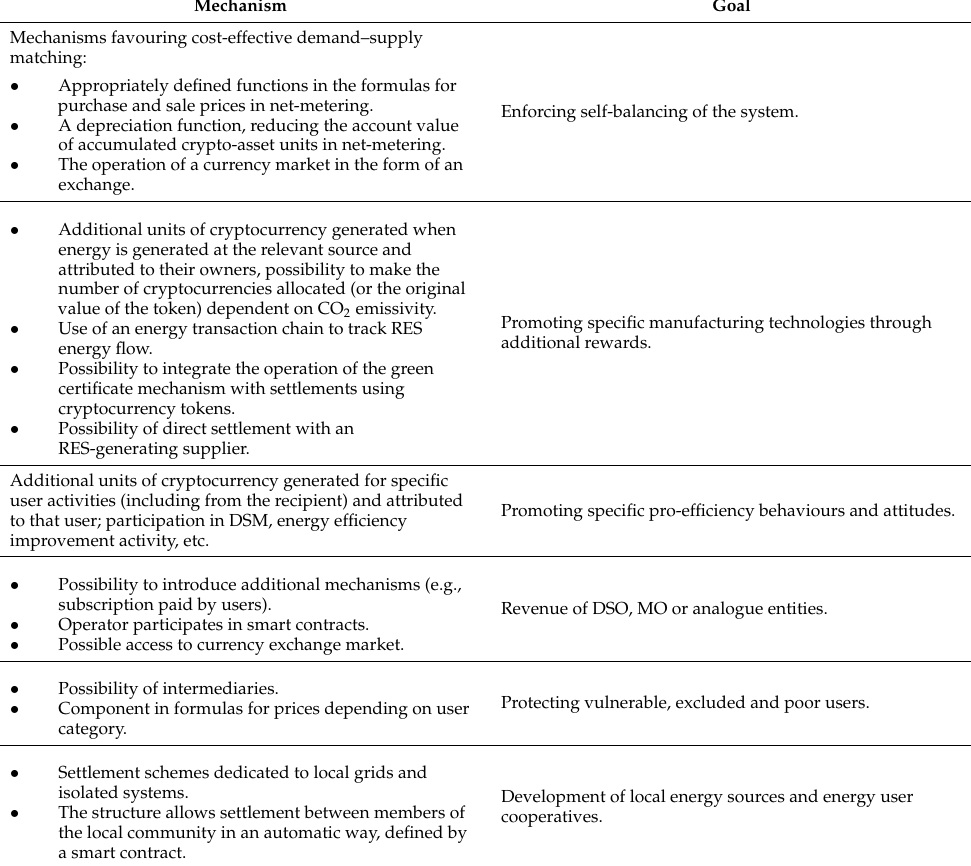
Table 4. Goals of the settlement system and mechanisms to help achieve them related to the cryp- tocurrency